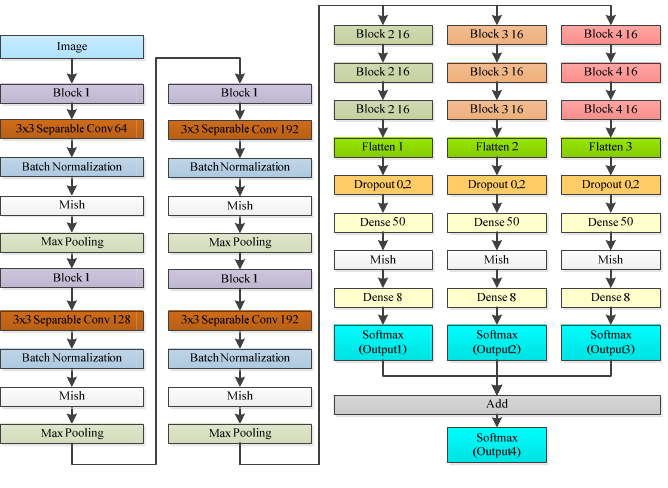
Figure 12. Model 2.